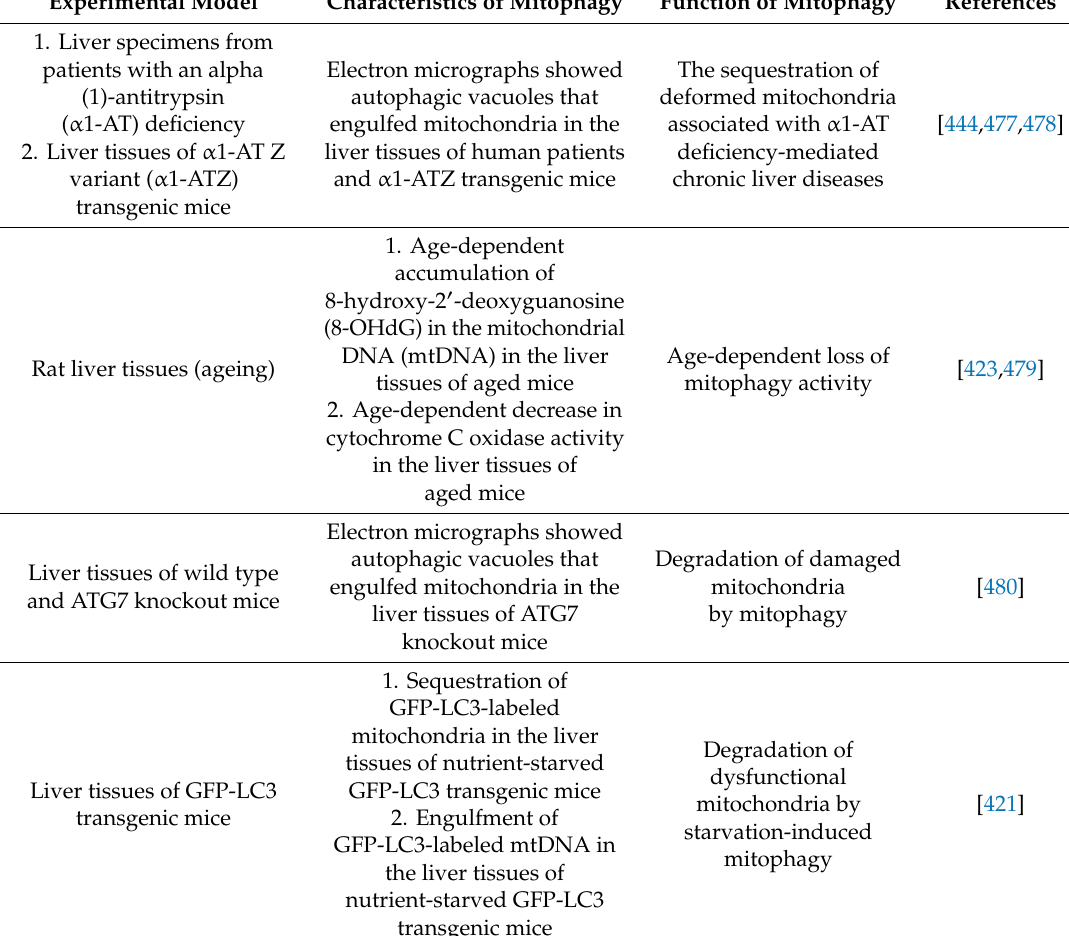
Table 1. Summary of the roles of mitophagy in liver